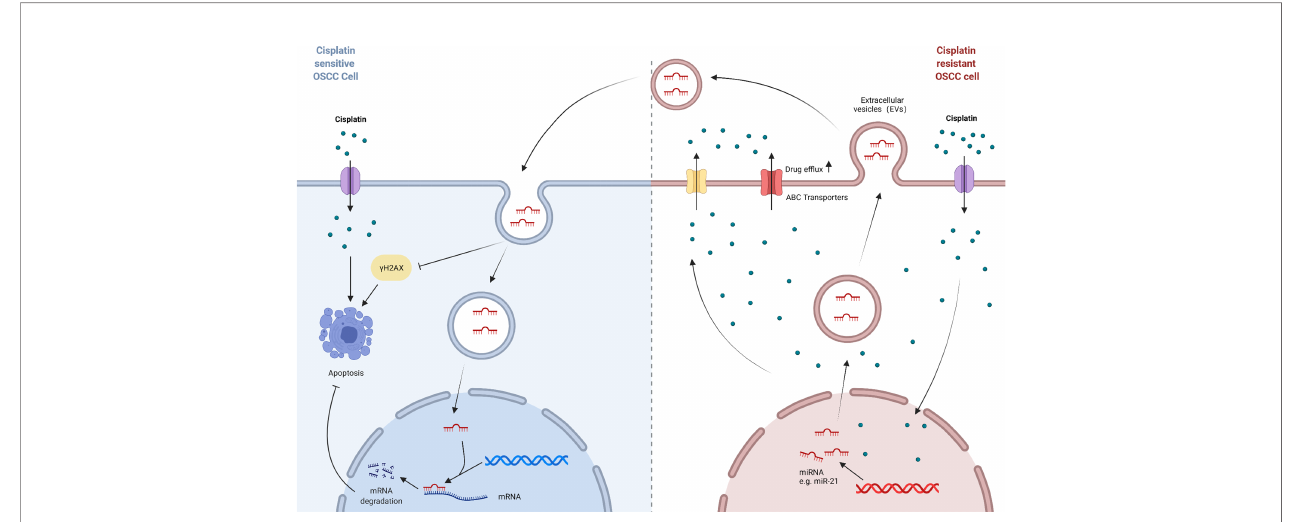
FIGURE 4 | A model of transport process-mediated cisplatin resistance in OSCC. ABC transporters act as transmembrane proteins that result in the ef fl ux of cisplatin from OSCC cells and reduce intracellular drug levels. And extracellular vesicles act as natural carriers of biological signals that can deliver substances such as functional RNAs from cisplatin-resistant OSCC cells to parental cells, thus enabling the propagation of cisplatin resistance in OSCC